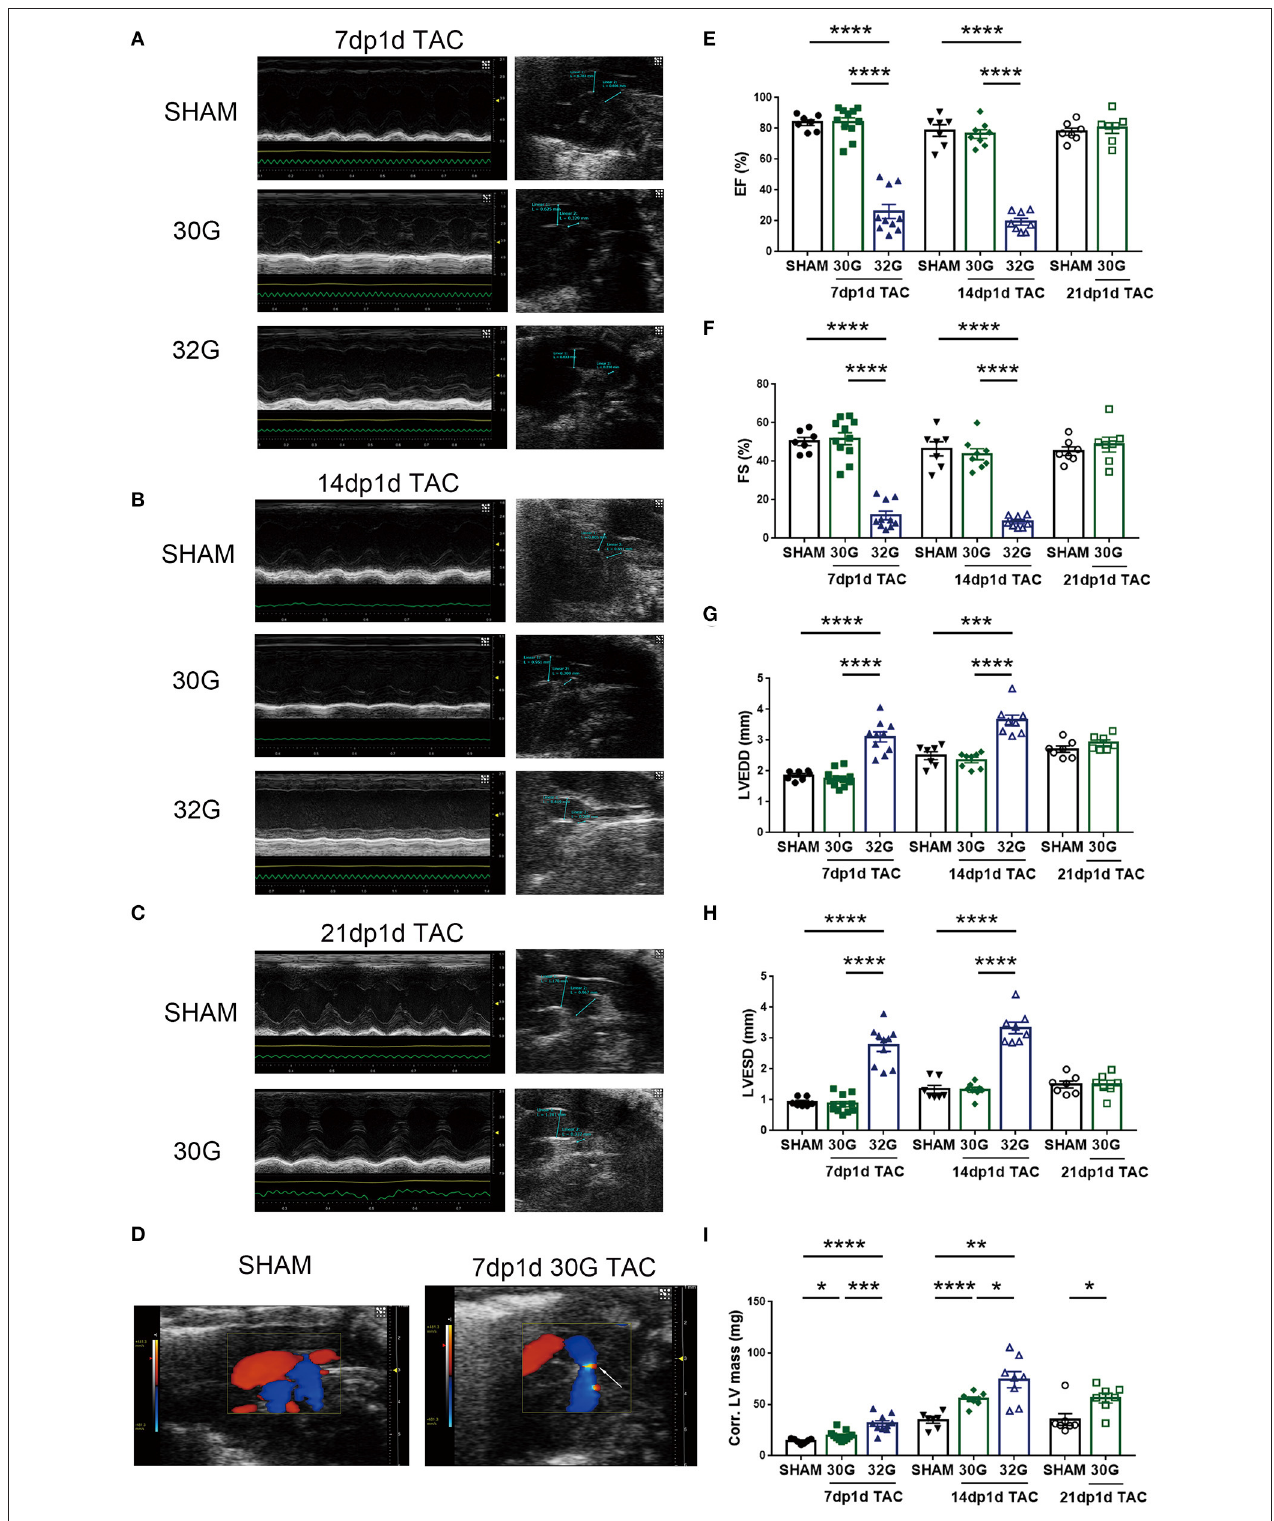
FIGURE 2 | Middle pressure overload significantly impaired heart function, while mild pressure overload did not. (A,B) Representative M-mode echocardiographic and aortic arch images of mice in the sham, 7dp1d TAC, and 14dp1d TAC groups with 30G and 32G constriction. (C) Representative images of